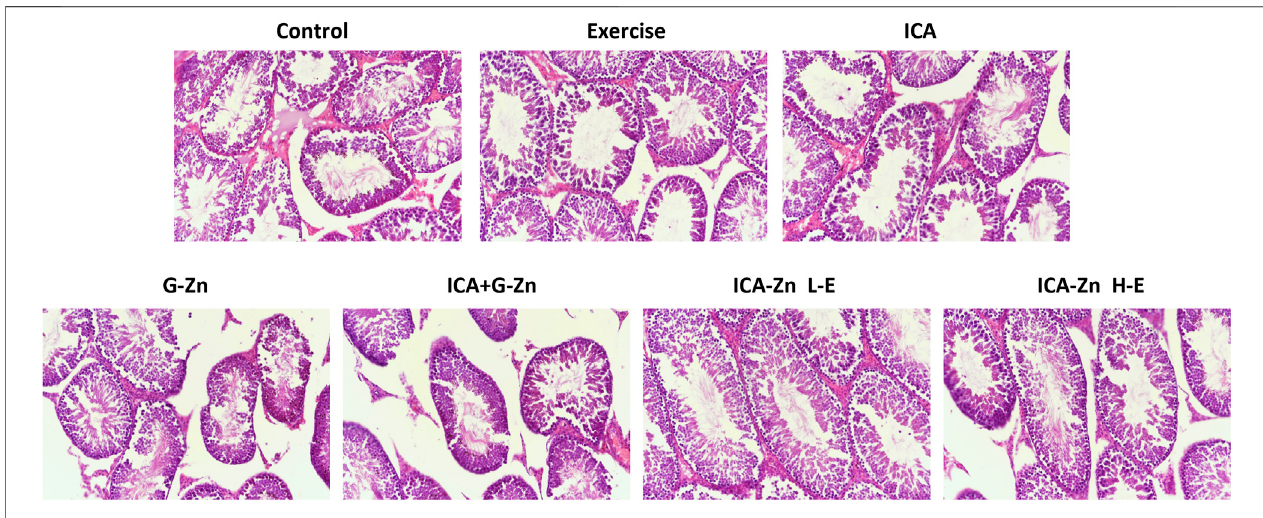
FIGURE 7 | HE staining of testes in rats (200x).